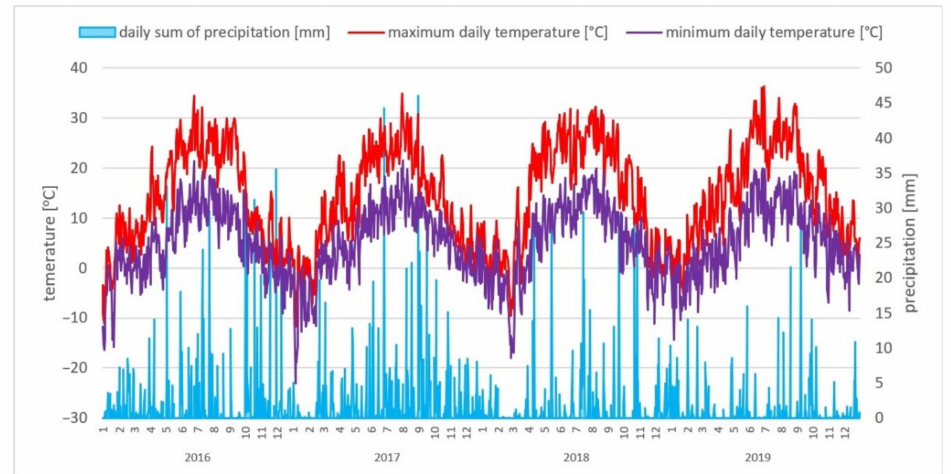
Figure 3. Differentiation of total daily precipitation and maximum and minimum daily temperatures in Ł ó d´z between 2016 and 2019. Source: own elaboration based on archival data of the Institute of Meteorology and Water Management at the National Research